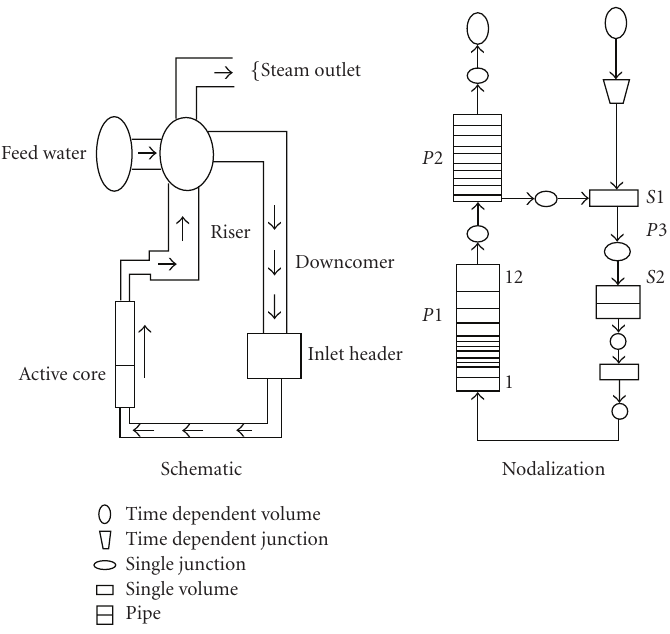
Figure 22: Example of university applications—natural circulation boiling water reactor applications by